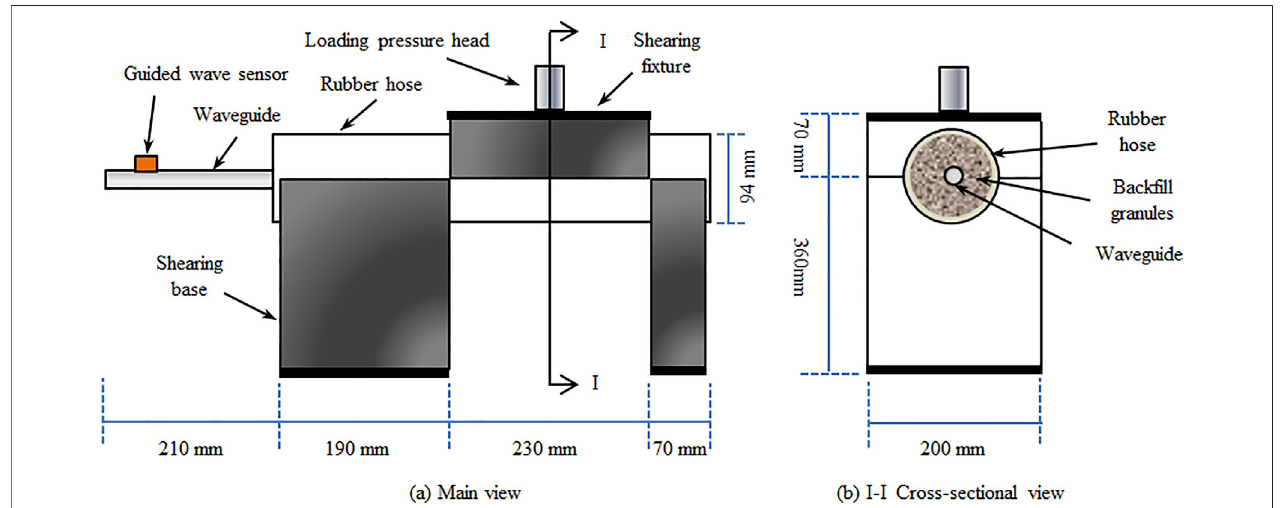
FIGURE 3 | Shear test of “ guided wave meter ”